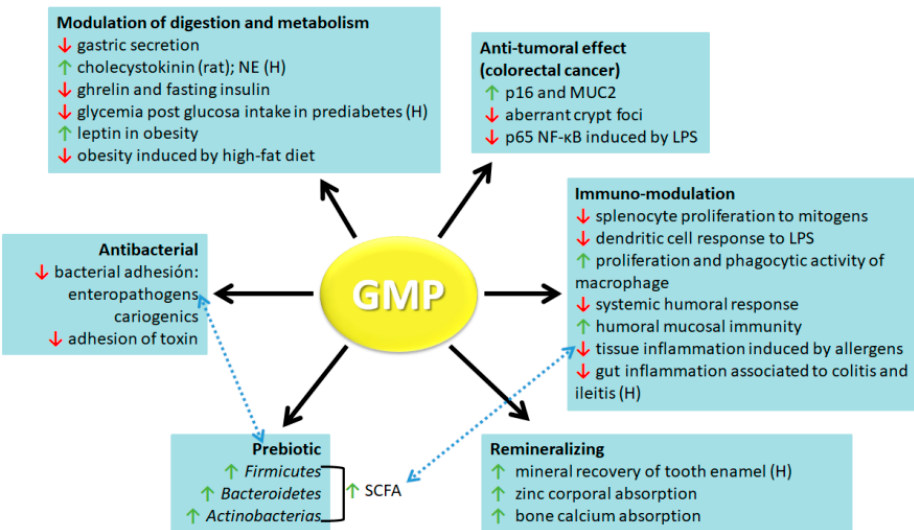
Figure 3. Biological activities ascribed to glycomacropeptide. The main biological activities of glycomacropeptide (GMP) with health-beneficial properties are antibacterial, prebiotic, remineralizing, modulation of digestion and metabolism, anti-tumoral, and immuno-modulation activities. Those activities demonstrated in clinical trials are indicated by (H). Red arrows indicate downregulatory effects and green arrows indicate upregulatory effects. Blue discontinuous arrows indicate associated mechanisms. NE, no effect; p16, cyclin dependent kinase inhibitor; MUC2, mucin 2; p65 NF- κ B, p65 nuclear factor- κ B subunit; LPS, lipopolysaccharide; SCFA, short-chain fatty acids.